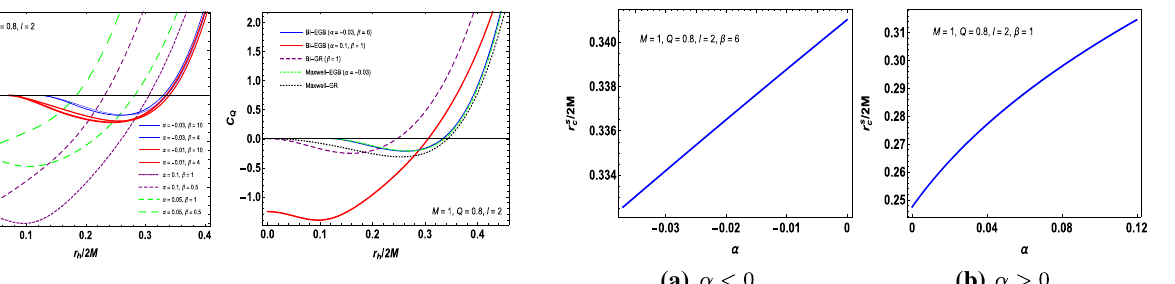
Fig. 5 The specific heat a for some parameter choices and b for the BI charged and Maxwell charged solutions in the novel 4D EGB gravity and GR